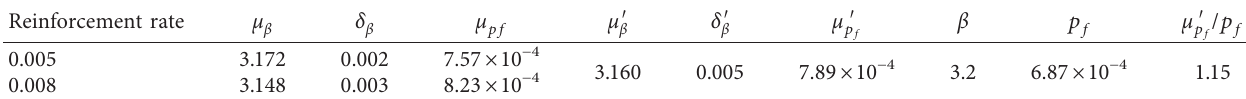
Figure 13: Concrete strength grade- β min curve. Table 14: Statistical parameters of the minimum reliable